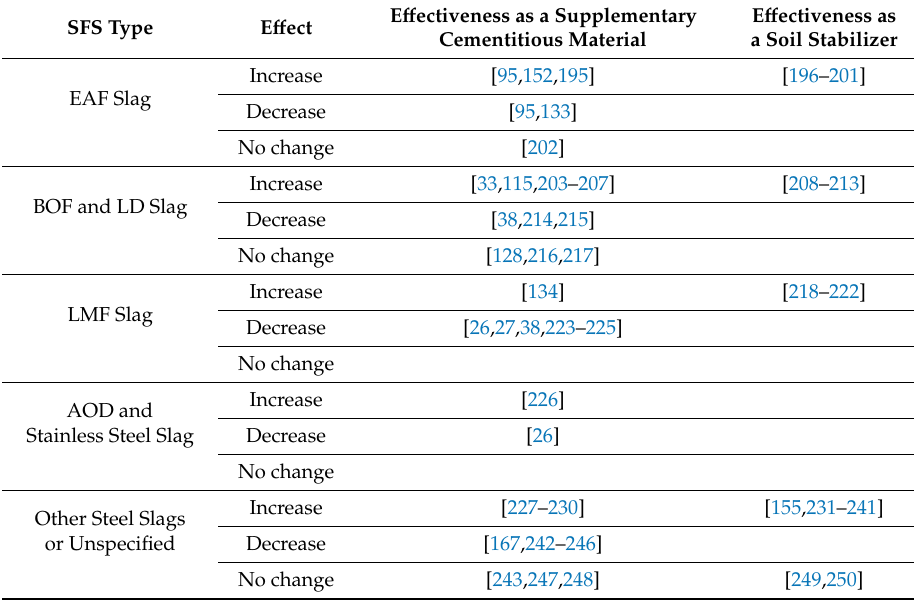
Table 4. E ff ect of SFS as a supplementary cementitious material or a soil